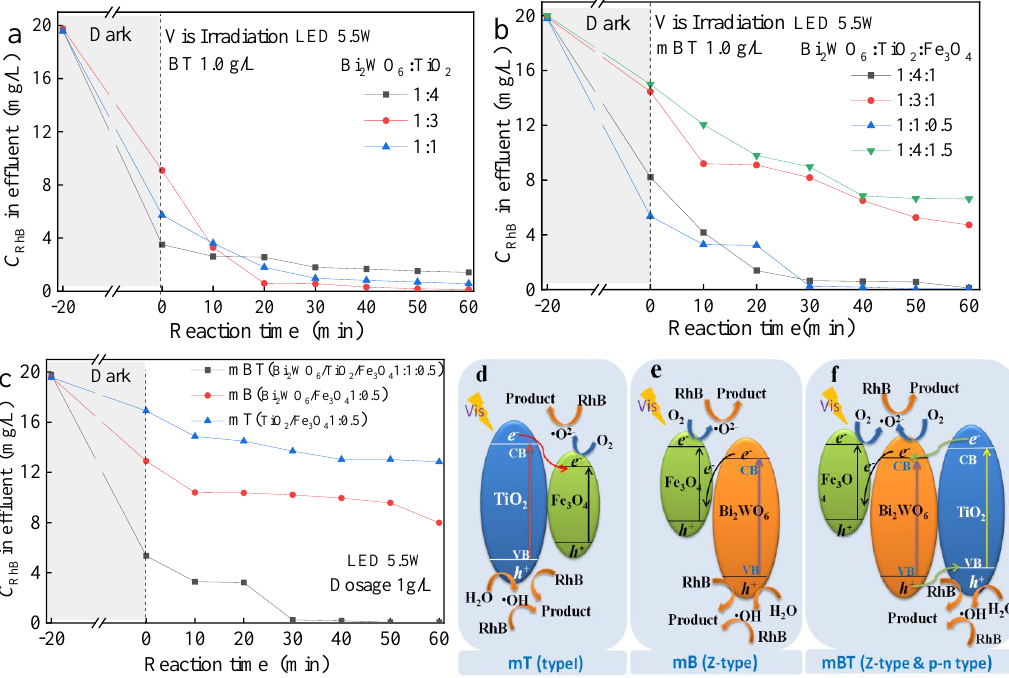
Figure 5. Degradation effect of RhB using Bi 2 WO 6 /TiO 2 (BT) ( a ) and mBT ( b ) at different molar ratios and using three kinds of magnetic photocatalysts ( c ) with their photocatalytic mechanisms ( d − f